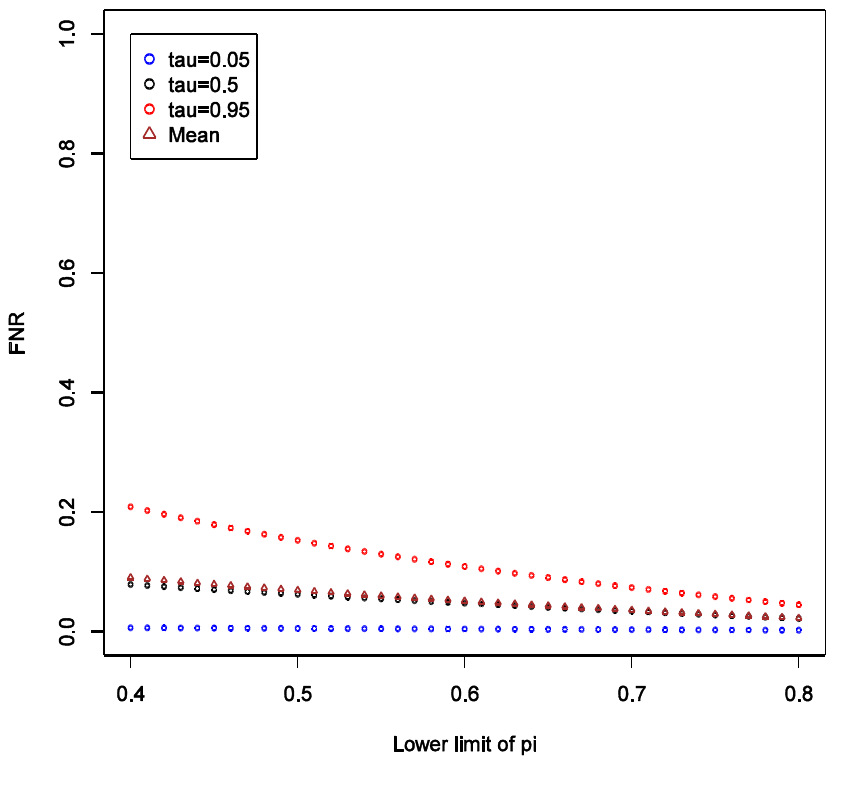
Figure 6. Theoretical calculations of the impact of varying strength belief in null hypothesis being true = pi (π); tau (τ) = expected quintiles of the distribution for false negative rate (FNR); see text for details of other parameter